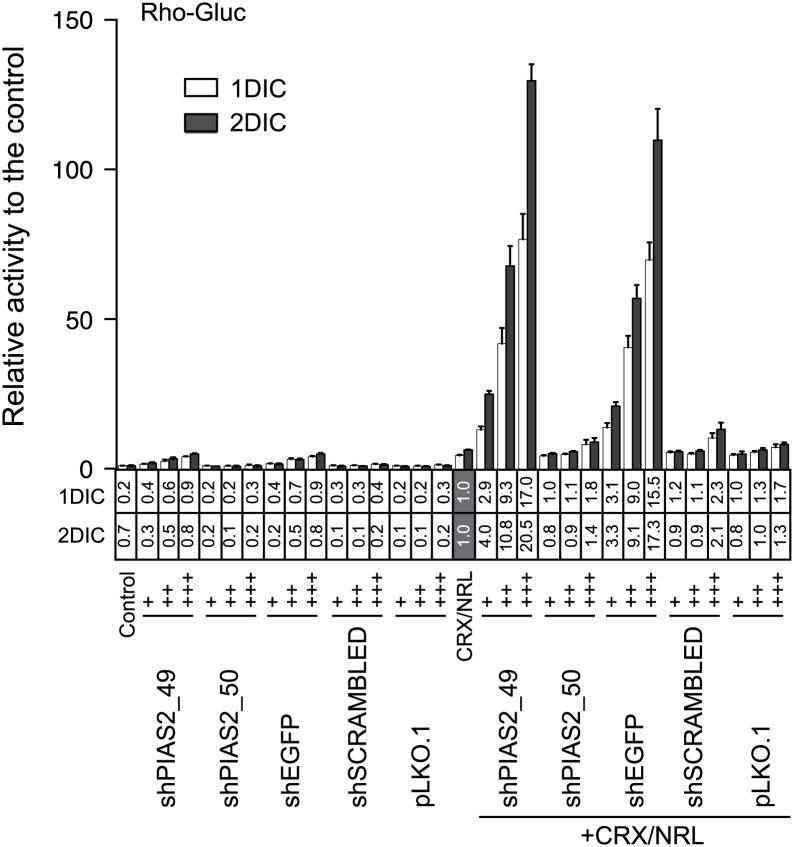
The effect of shRNA on the rho-Gluc activity is target-gene-independent.HEK293 cells were transfected with rho-Gluc reporter and the indicated shRNA with or without CRX and NRL expression vectors. '+', '++', and '+++' represent 8, 40, and 200 ng, respectively, of the indicated shRNA plasmid DNA. As a control, 500 ng of empty pcDNA3 with 100 ng reporter vector was transfected into HEK293 cells. Gaussia luciferase activity was measured in culture media one and two days after transfection. Relative luciferase activity to the control (bar graph) and the CRX/NRL transfected sample (in the column under the bar graph) are presented. Error bars are shown as SE.